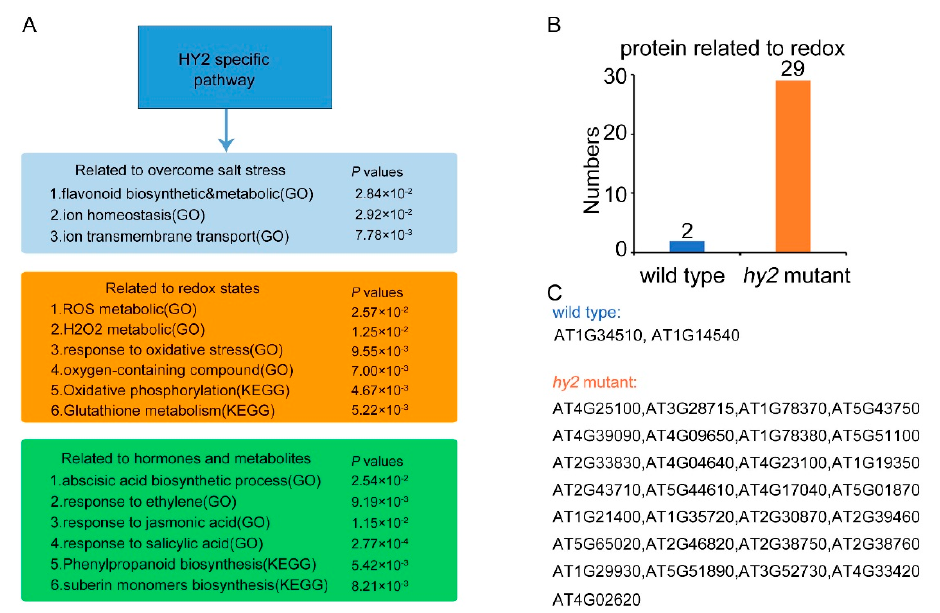
Figure 5. HY2-specific regulated pathway analysis. ( A ) GO enrichment and KEGG enrichment analysis models of HY2 specifically regulated proteins under salt stress. The light blue module represents the pathway related to the overcoming of salt stress, the yellow module represents the pathway related to redox states, and the green module represents the pathway related to hormones and metabolites. ( B , C ) The proportion of redox-related proteins in wild-type and hy2 mutant among the proteins specifically regulated by HY2.